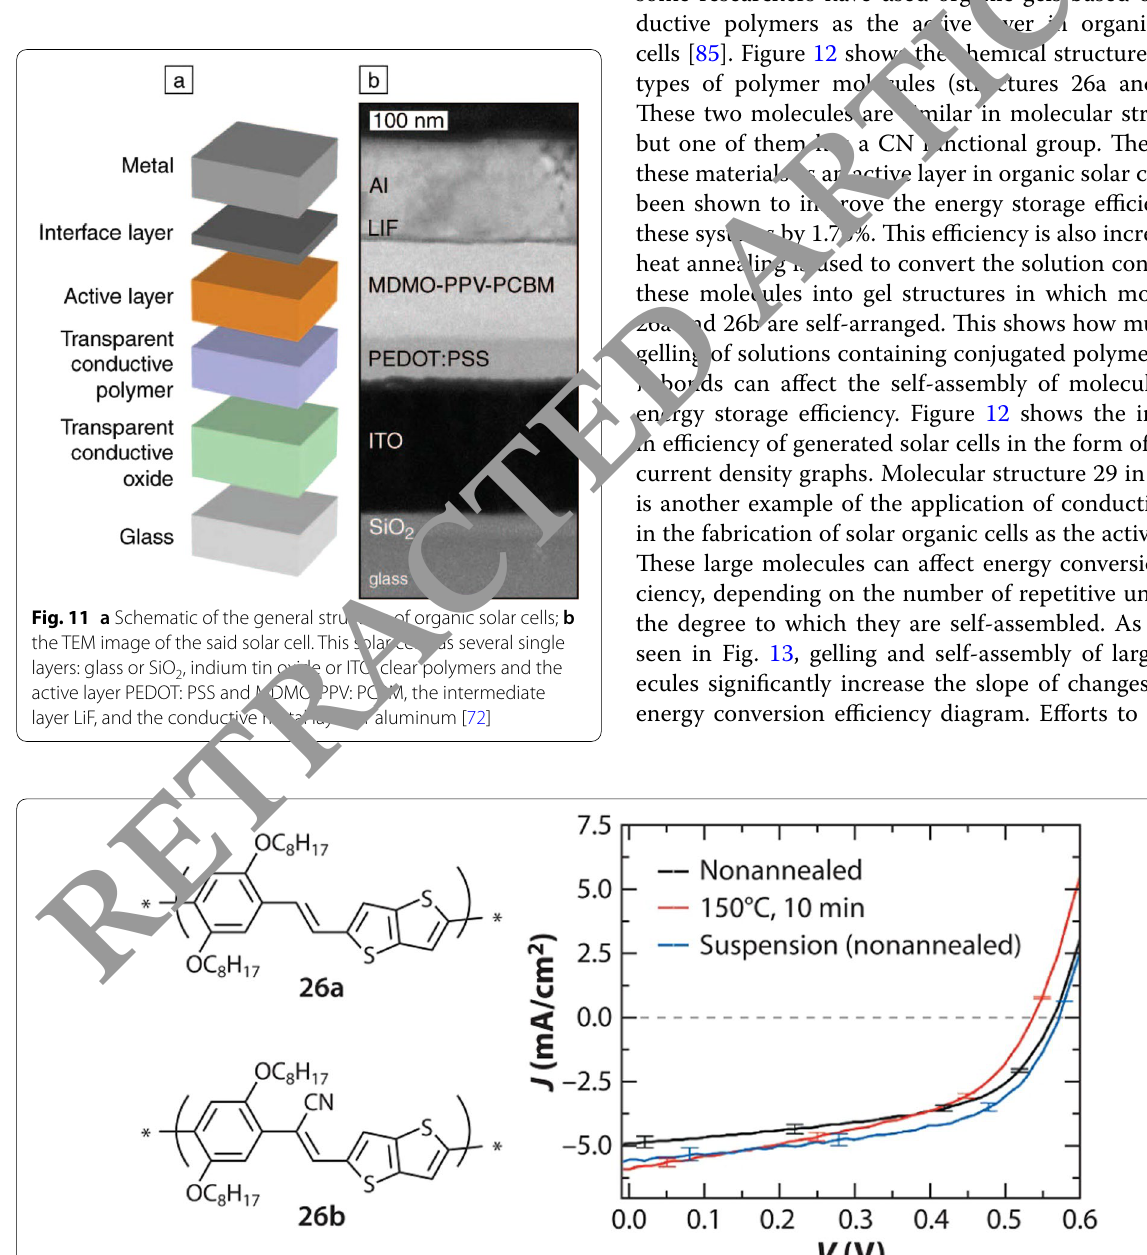
Fig. 12 Chemical structures of conductive organic gels (structures 26a and 26b) and energy conversion efficiency diagrams in annealed and non-annealed samples. Annealing only results in molecular self-assembly of conjugated polymers with π bonds